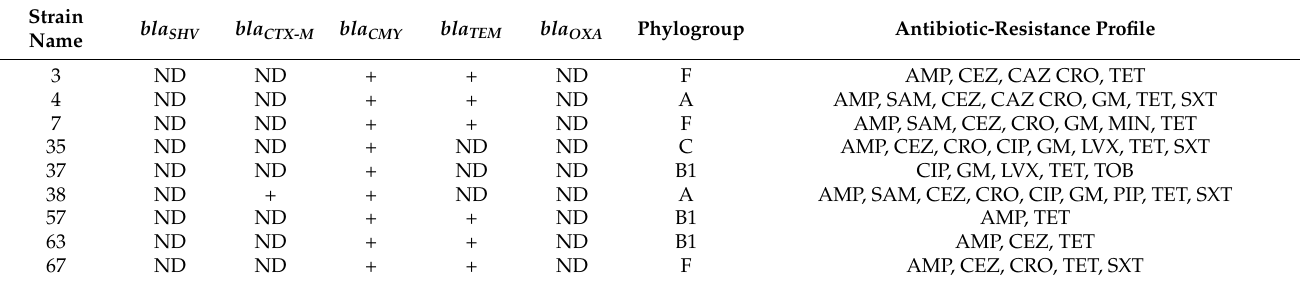
Table 3. Molecular characterization and antimicrobial resistance profile of bla CMY -positive Escherichia coli isolates ( n = 9) derived from chicken